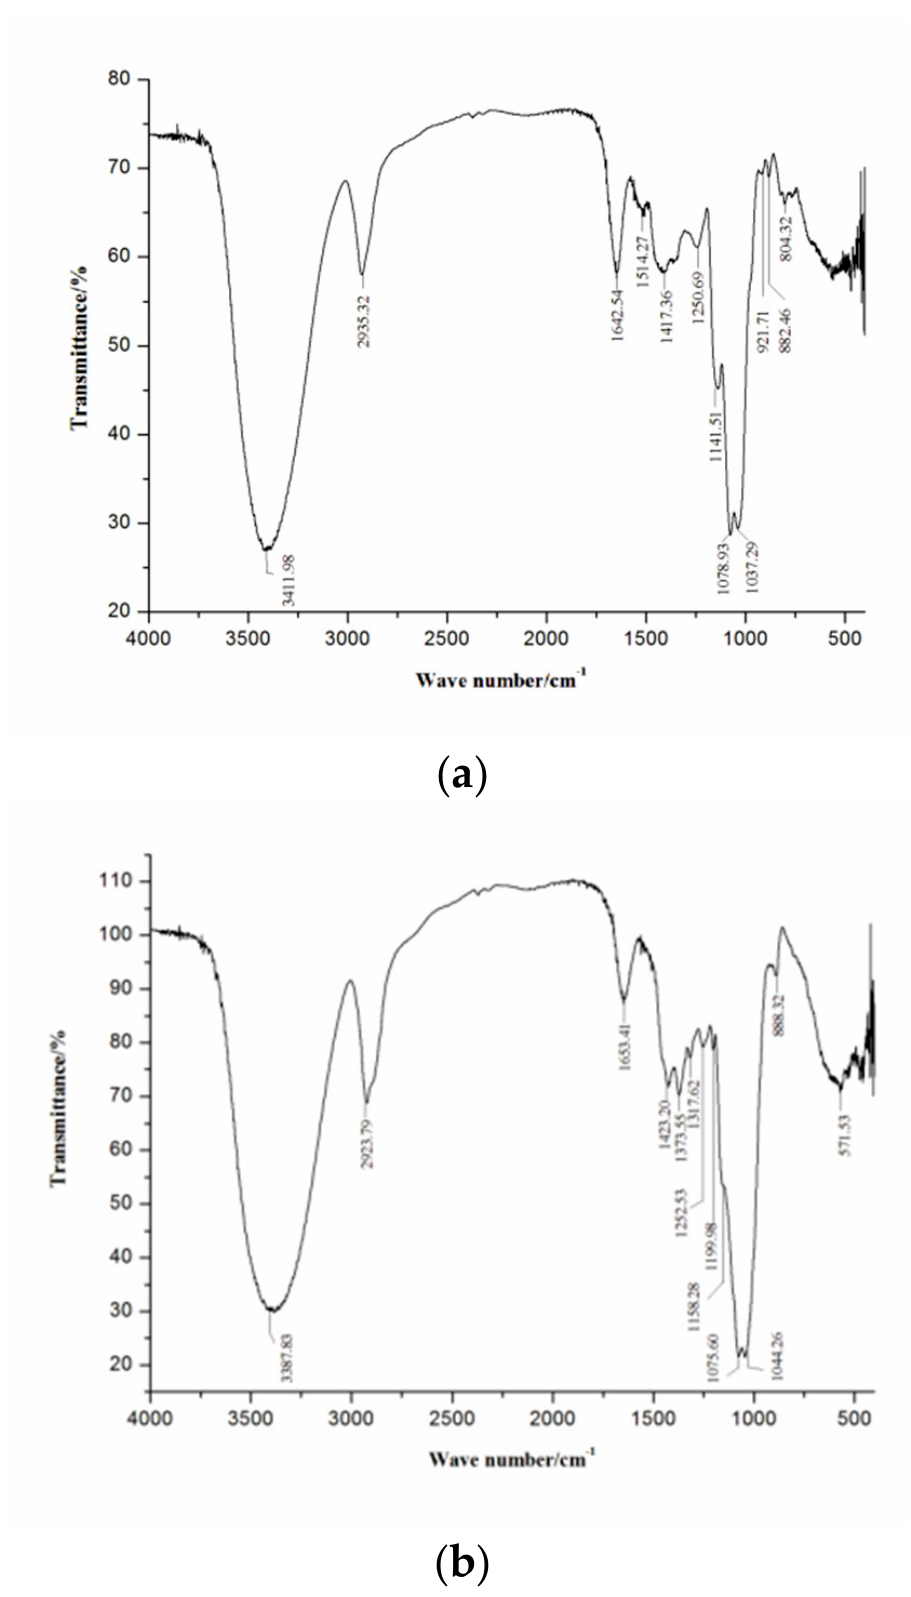
Figure 3. ( a ) The Fourier ‐ transform infrared (FT ‐ IR) spectroscopy of CHFVP ‐ 1; ( b ) The FT ‐ IR spectroscopy of CHFVP ‐ 2.